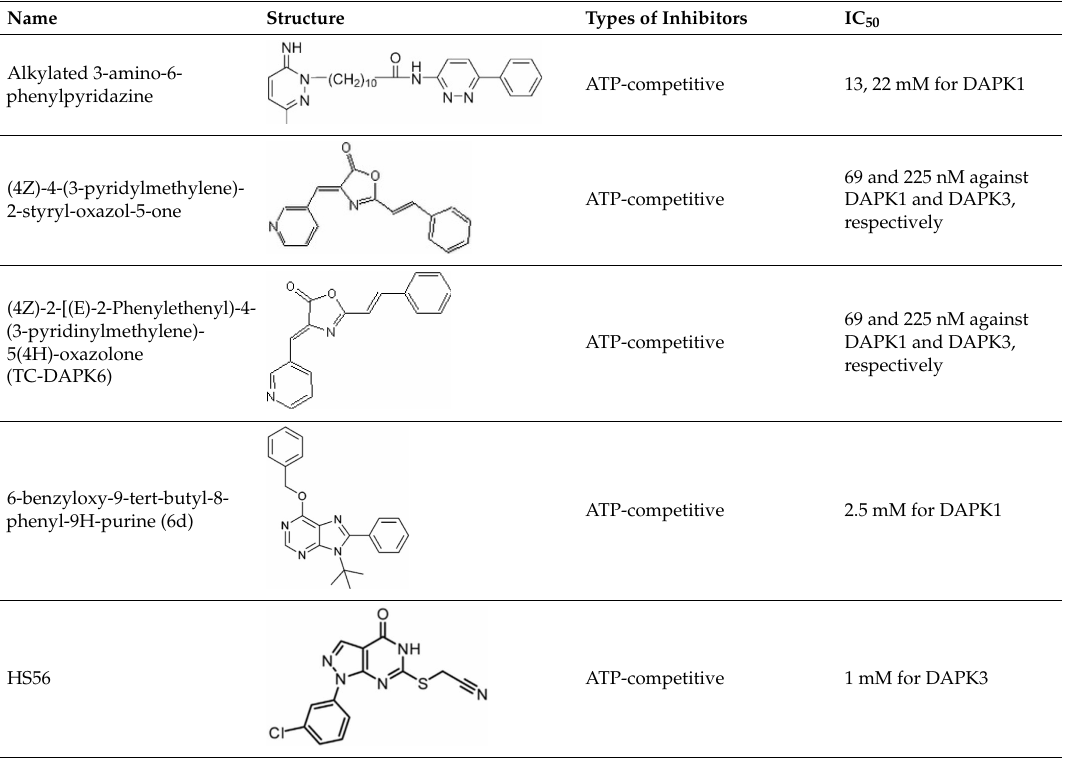
Table 1. Information on DAPK